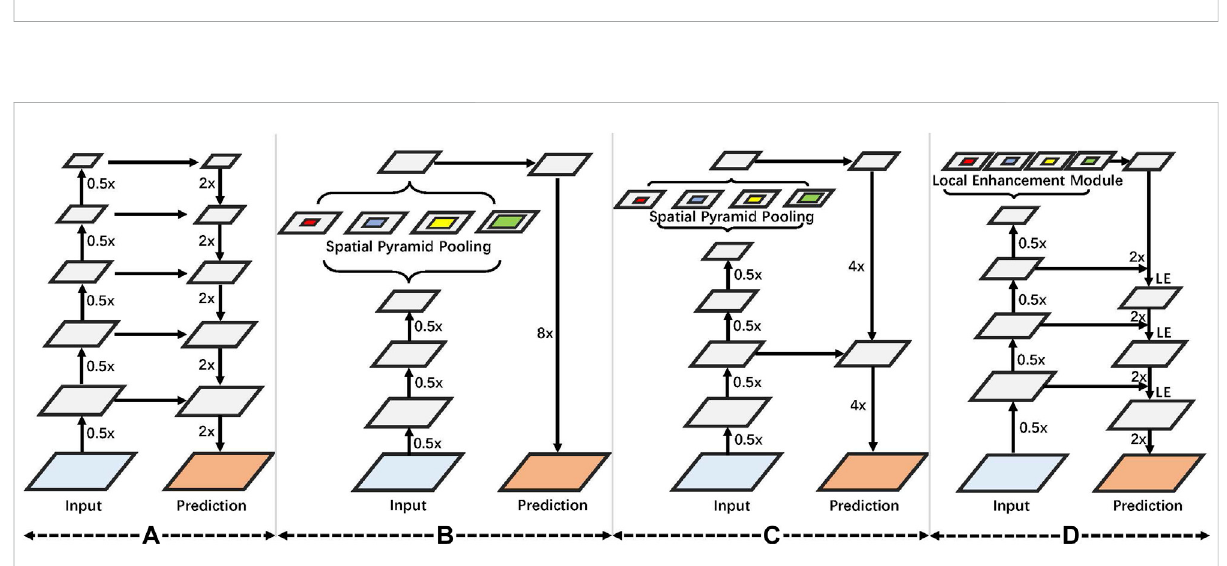
FIGURE 2 Overview of the proposed tooth segmentation pipeline. LE denotes the local enhancement module. We fi rst designed a local context enhancement module for tooth CBCT images and then integrated the proposed module into the encoder – decoder network. In addition, various decoding modules are optimized through cross-entropy